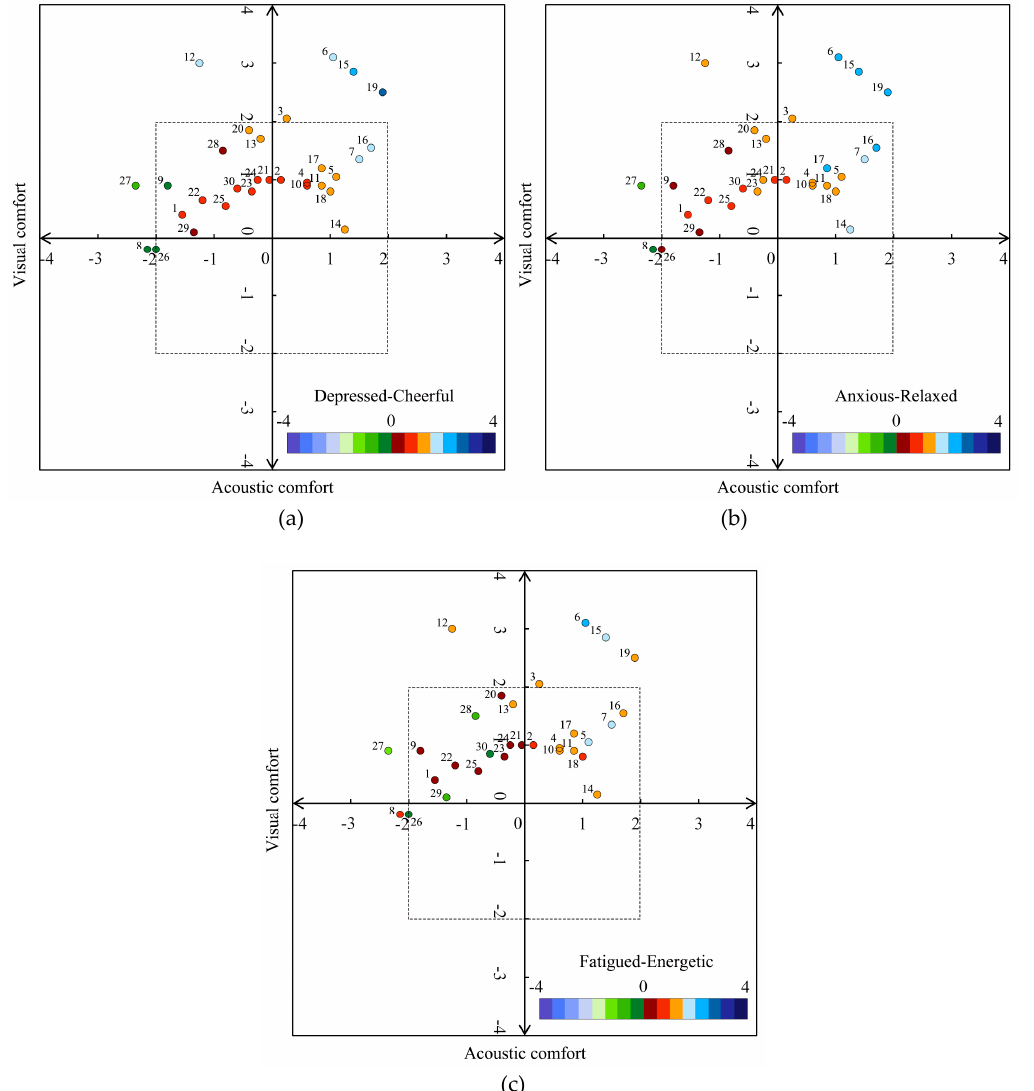
Figure 1. Orthogonal analysis of audio-visual experiences on psychological responses: ( a ) cheerful- depressed (CD); ( b ) relaxed-anxious (RA); ( c ) energetic-fatigued (EF) in Cloves Park.